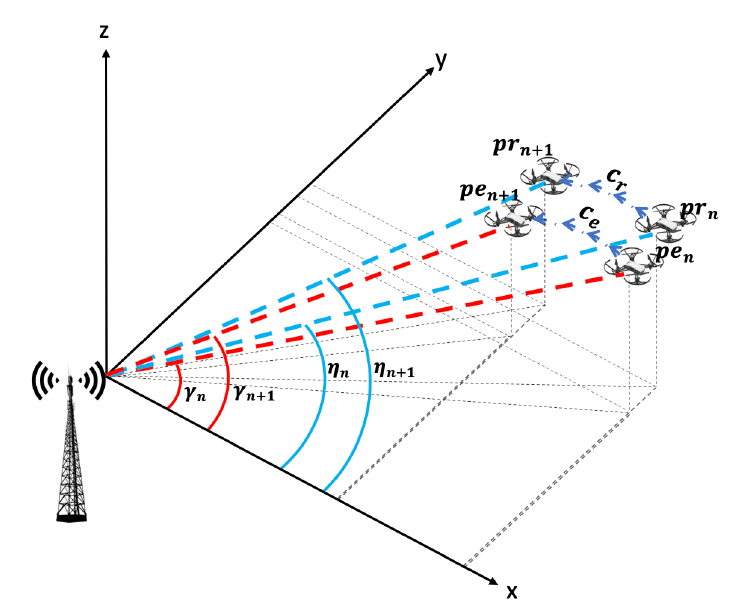
Figure 4. Illustration of the prediction method.